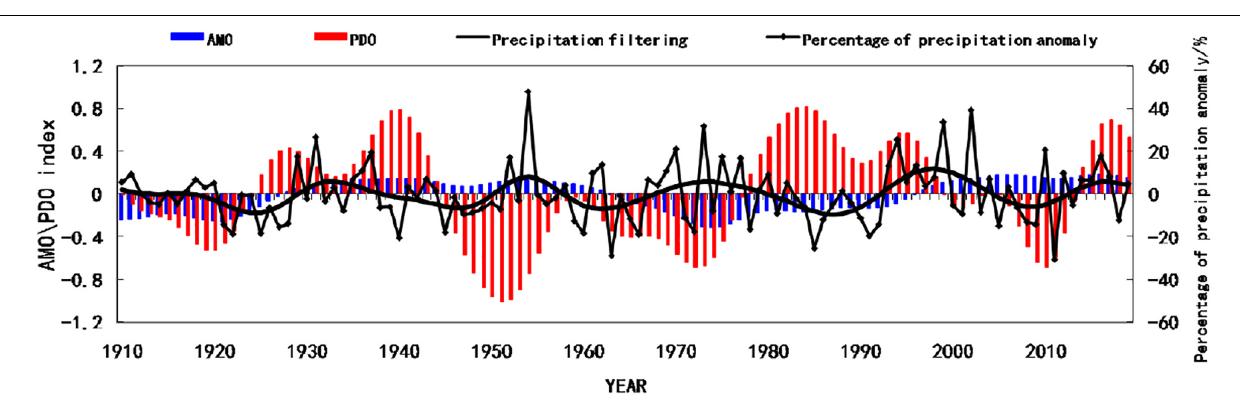
FIGURE 3 | Temporal variations of the AMO index, the PDO index, the precipitation and the precipitation anomaly percentage in Hunan flood seasons during